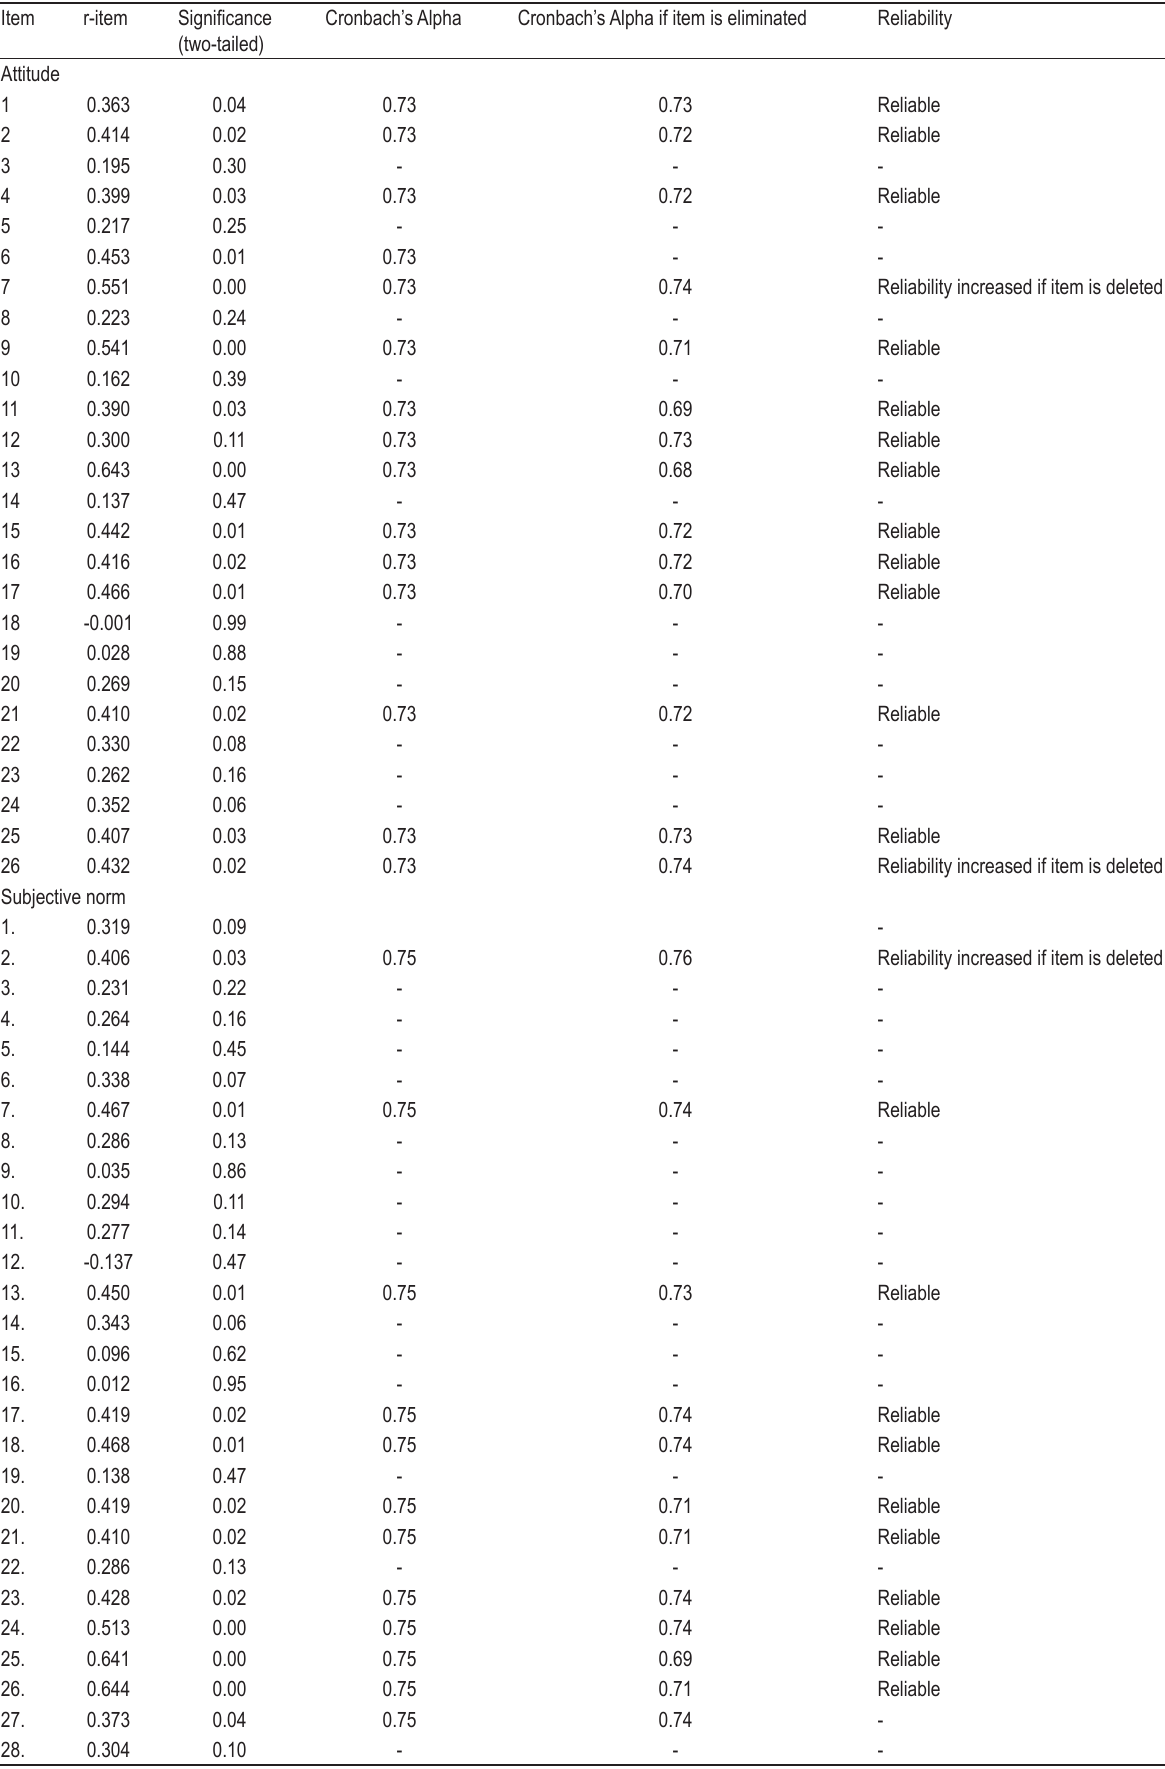
TABLE 4. Item analysis and Cronbach’s Alpha value on attitude, behavioral control, and intention